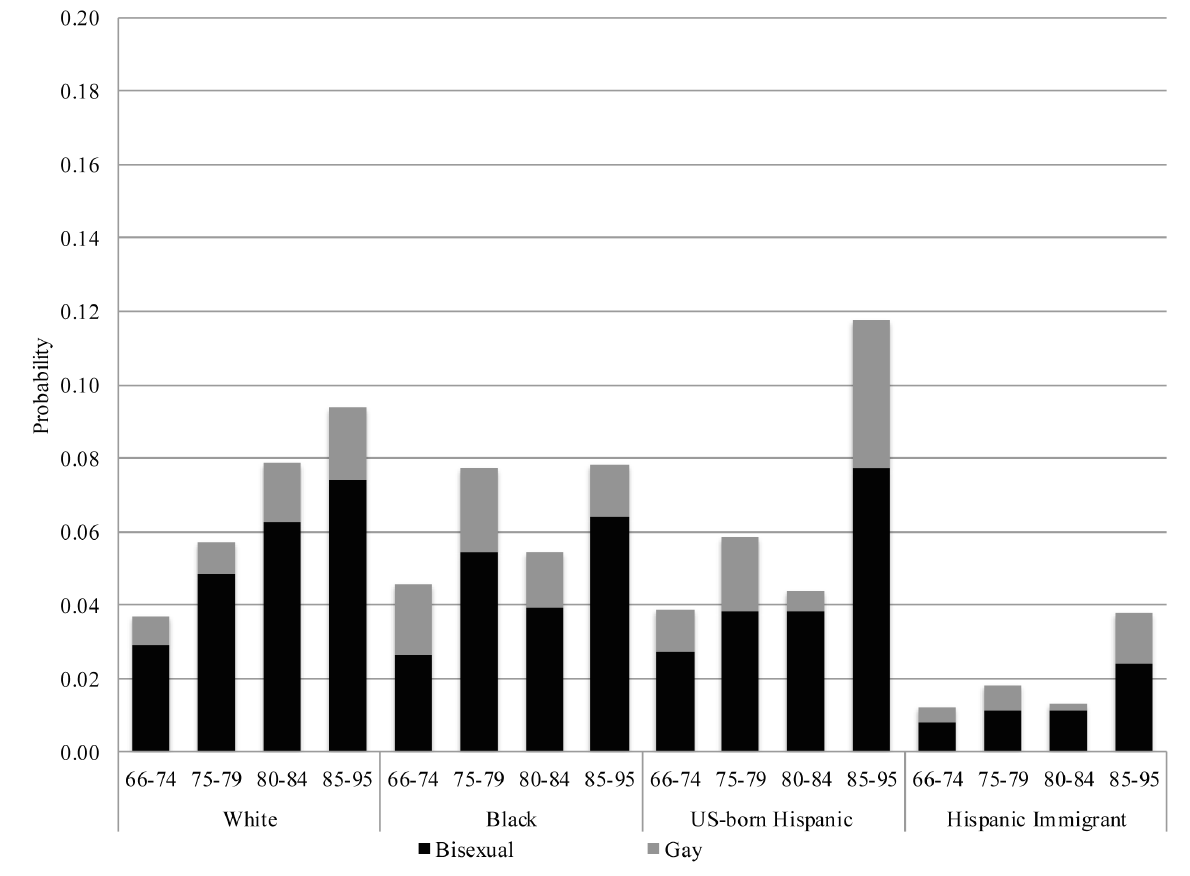
Figure 4: Women’s predicted probability of identifying as bisexual or gay, by birth cohort and race. not significantly different. The upward trends were also largely the same across socioeconomic background groups (measured by mother’s